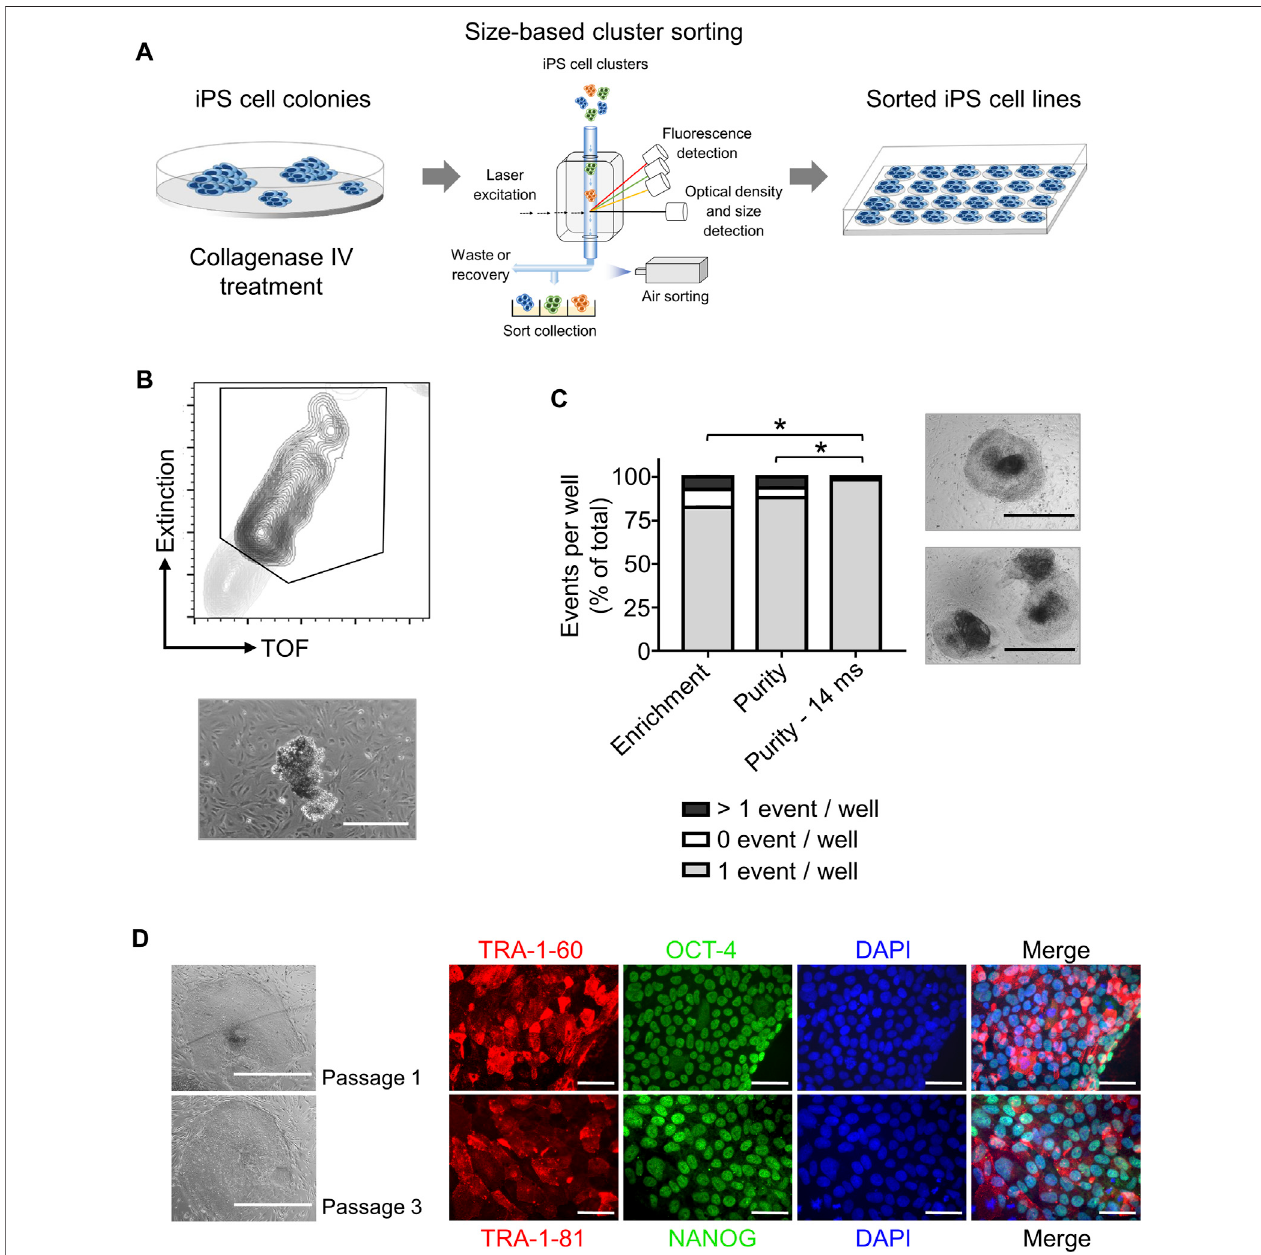
FIGURE 2 | High throughput automated sorting of iPS cell clusters enables the generation of iPS cell lines without compromising pluripotency. (A) Schematic representation of experimental design. iPS cells are cultured on MEF feeder in 10 cm dishes until a con fl uency of 70% is reached. iPS cell colonies are detached by collagenase IV treatment and sorted by large particle sorter COPAS FP-1000 into a 24 well-plate. (B) Representative gating strategy (top) used to sort iPS cell clusters and representative image of an iPS cell cluster after sorting (bottom, scale bar: 500 µm). (C) Quanti fi cation of sorting ef fi ciency for each sorting method used (enrichment, purity, or purity — 14 ms) based on the number of iPS cell clusters (events) per well in a 24-well plate. Purity method with optimized delay time of 14 ms resulted in most of the wells containing only one iPS cell cluster (event) allowing clonal expansion of iPS cells. Phase contrast microscopy images on the right show iPS cell colony morphology 2 days after cluster sorting of one event per well (top) and > 1 event per well (bottom). Scale bar: 1 mm. Statistical analysis was performed with Welch´s t -testcomparingthenumbersofwellscontainingoneeventaftersortingwithdifferentprotocols:enrichment( n =3),purity( n =6)orpuritywithdelayof14 ms( n = 8). *= p < 0.0001. (D) Representative phasecontrastmicroscopyimagesofiPS cellsgeneratedafter sorting showingmorphology ofpluripotentcells afteroneand three passages(Left, scalebar:1 mm).PluripotencyofsortediPScellswasfurthercon fi rmedbyimmuno fl uorescencestainingforthepluripotencysurfacemarkersTRA-1-60 and TRA-1-81 and the pluripotency associated transcription factors OCT4 and NANOG. Nuclei are stained with DAPI. n = 1. Scale bar: 100 µm.